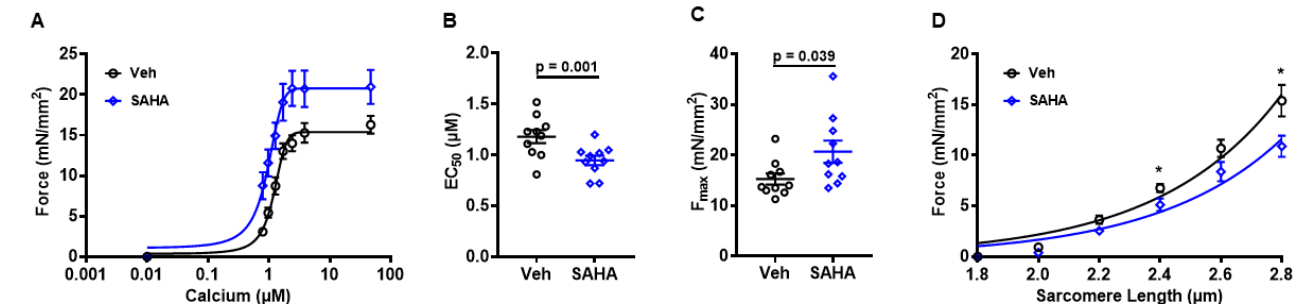
Figure 2. Effect of SAHA treatment on AFVM myofilament function. Skinned myocytes were isolated from AFVM to assess myofilament function. The ( A ) average force-calcium curves for SAHA and vehicle-treated skinned myocytes demonstrate a clear left shift with SAHA treatment. There was a decrease in the ( B ) EC 50 with SAHA treatment, indicating an increase in myofilament calcium sensitivity and an increase in ( C ) maximal calcium-activated force (F max ); n = 10 myocytes from 3 felines for each group. There was a decrease in ( D ) passive stiffness at increasing sarcomere lengths. n = 8 vehicle treated myocytes from 3 felines, n = 10 SAHA-treated myocytes from 3 felines. All analysis was performed using a two-sided Student’s t -test. * p < 0.05 Data shown are means ±